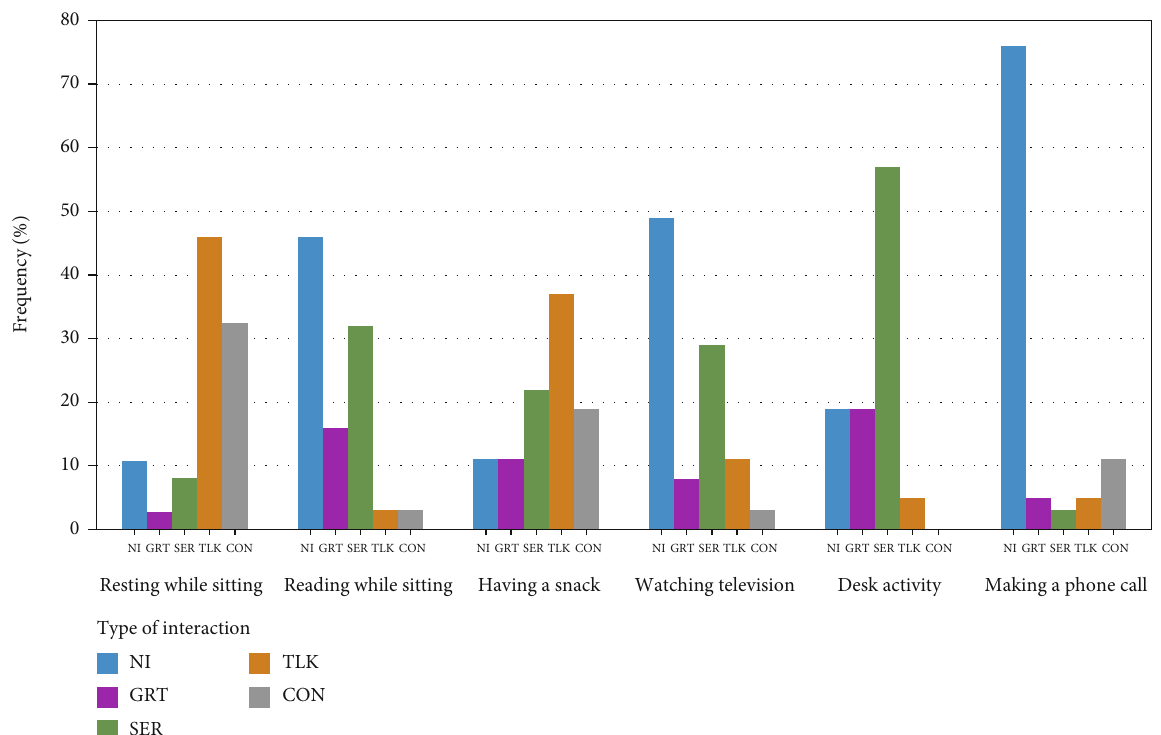
Figure 9: This graph depicts how the users picked up conversational preferences during the selected tasks while the domestic area and people in the surrounding were kept constant. Here, the domestic area was the living room, and the user was alone in the